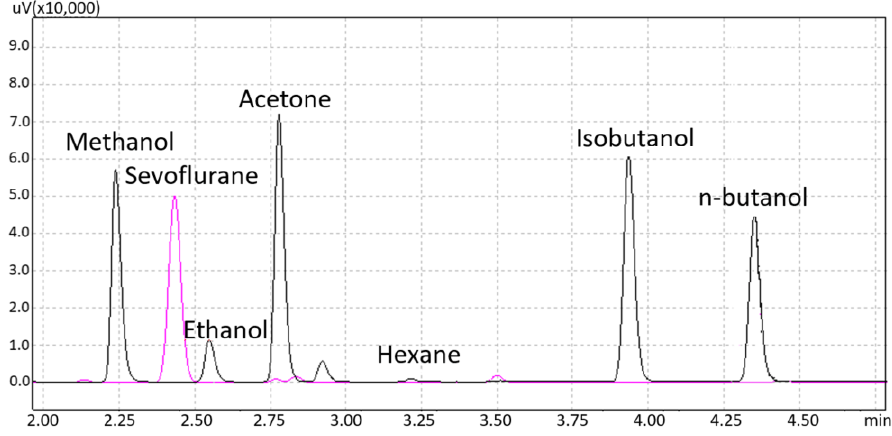
Figure 3. Chromatograms of sevoflurane and the other volatiles tested.